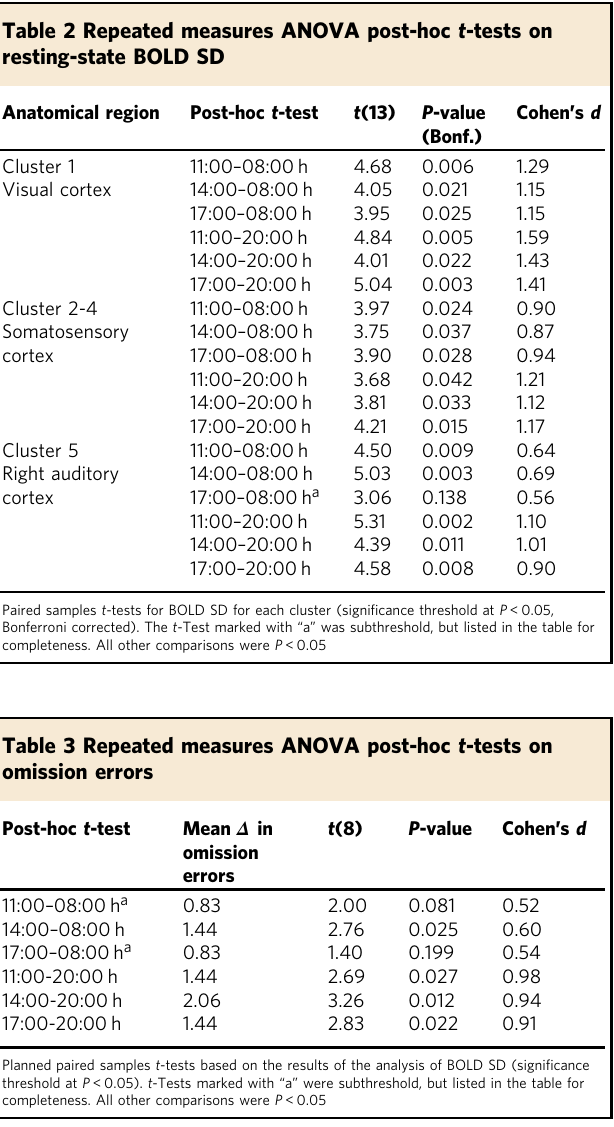
completeness. All other comparisons were P variance reductions to performance requires correlating not only